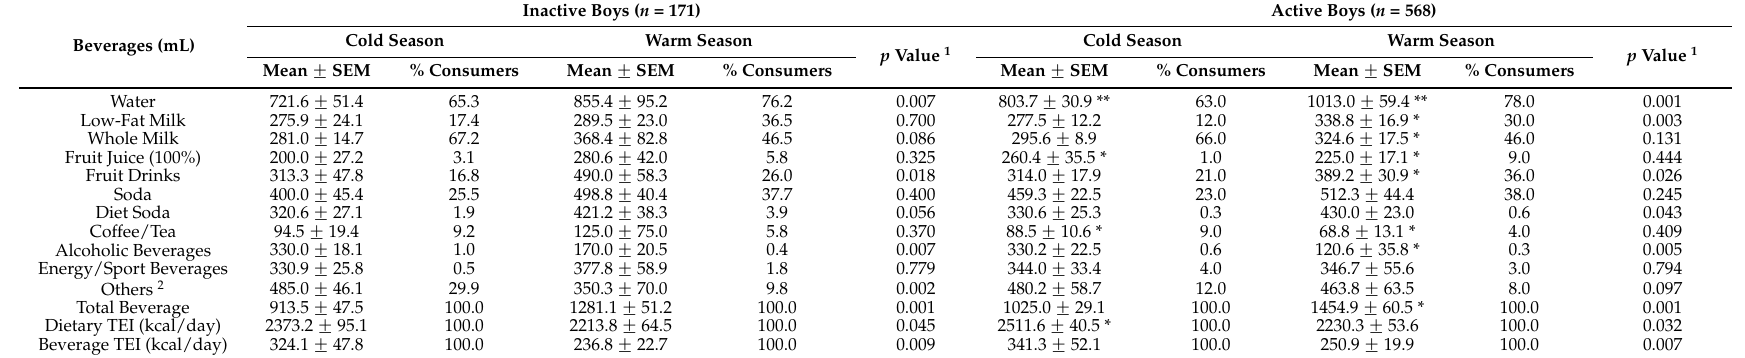
Table 3. Daily beverage (mL), energy intake and percentage of consumers among active and inactive boys according to the